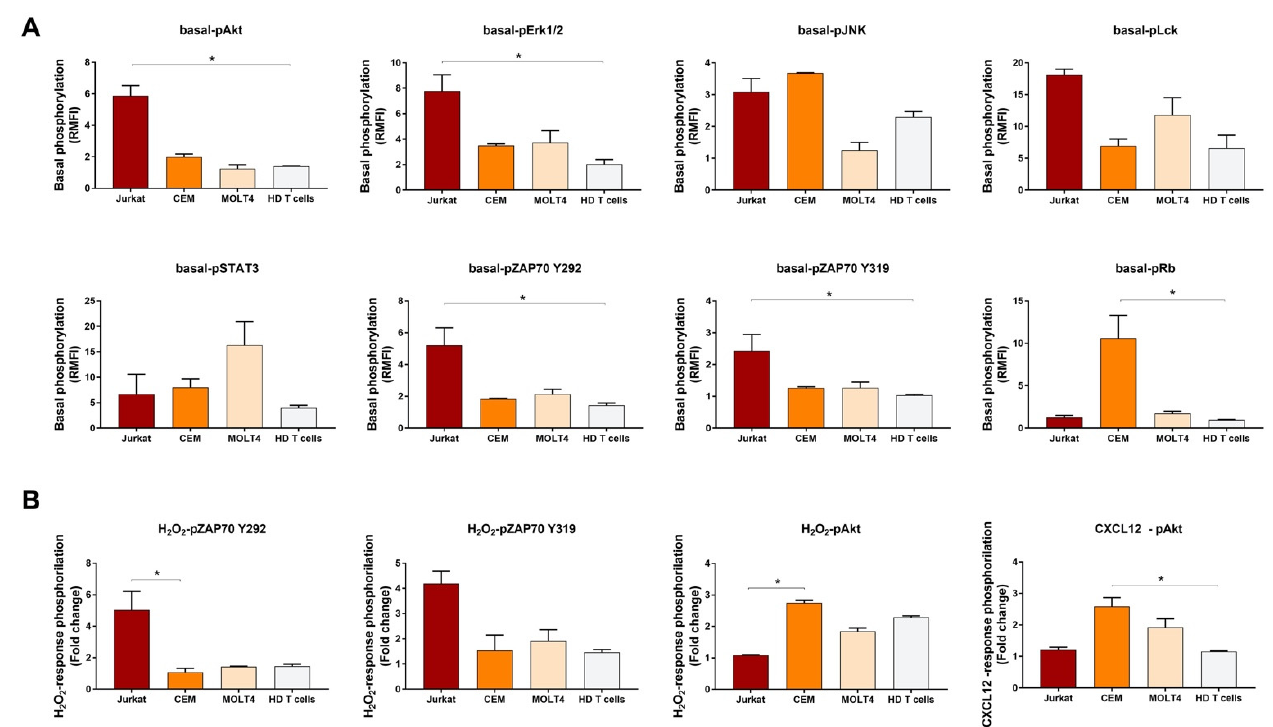
Figure 5. Histograms of phosphorylation levels in T-ALL cell lines and HD T cells. ( A ) Comparison of phosphorylation levels in the basal condition, relative to isotypic controls, among T-ALL cell lines and healthy donor (HD) T cells. ( B ) Comparison of response to stimulation, relative to the unstimulated condition, among T-ALL cell lines and HD T cells. Data are expressed as mean ± SEM from three, independent experiments. Comparisons were performed using the Kruskal–Wallis test and each P value was corrected for multiple comparisons using the Dunn’s test (* p ≤ 0.05).